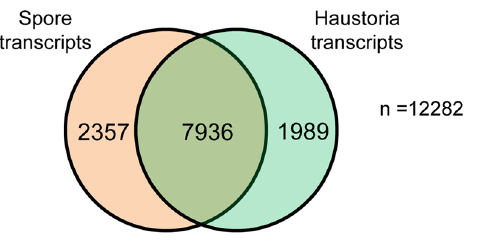
Figure 2. Differential gene expression in Pst germinated spores and haustoria. Venn diagram of reference transcripts set, showing the number of transcripts that did not show differential expression between the two tissues, and those that had statistically significant changes in expression between germinated spores and haustoria.